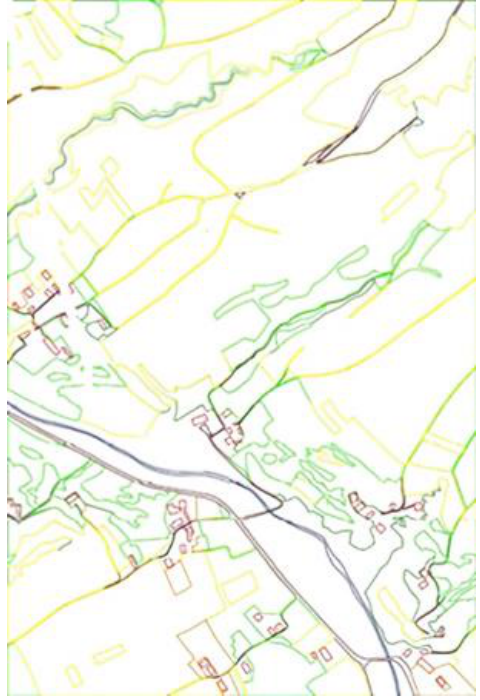
Figure 6. Orthophotomap from 2010. The layers were successively vectorized, and the results of the work are shown in Figures 7 and 8.